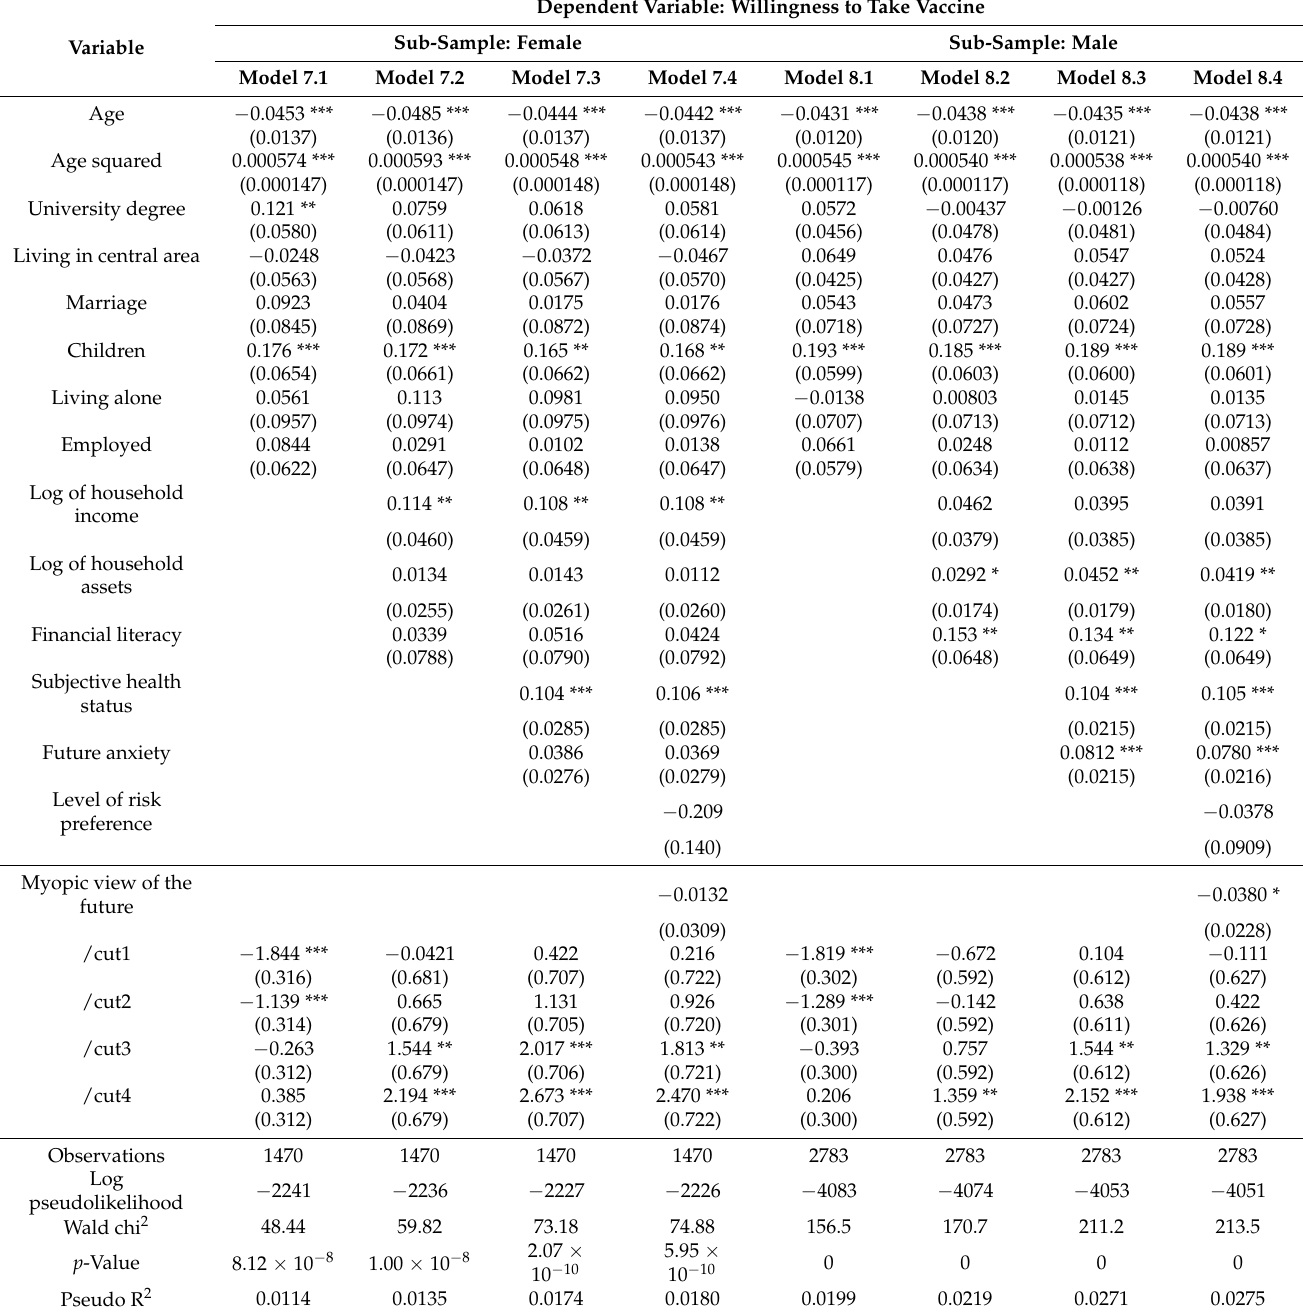
Table 9. Ordered probit model regression results (subsample analysis: